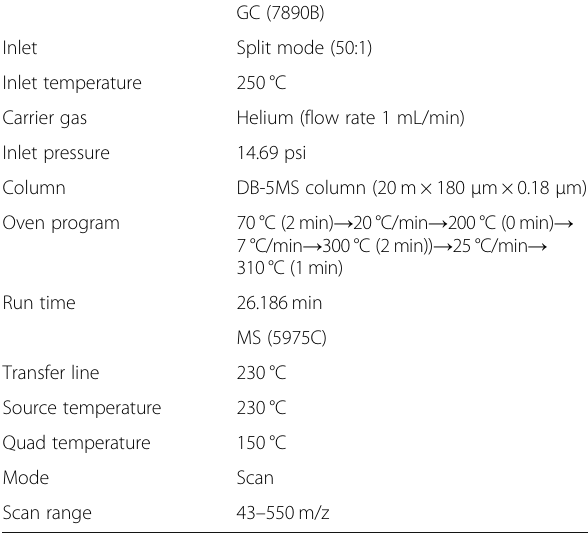
Table 1 Analytical parameters of